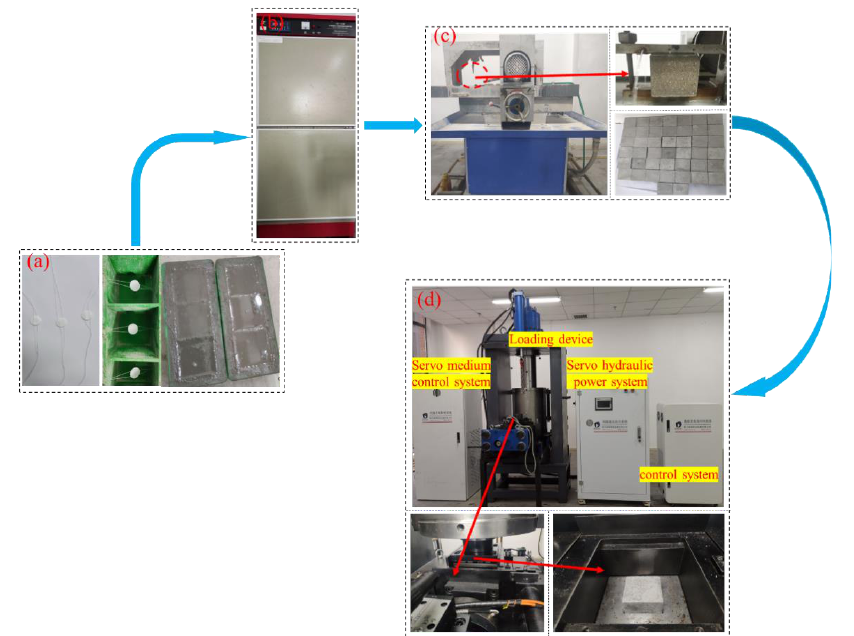
Figure 3. Sample preparation and shear test equipment: ( a ) preparation of the samples before pouring; ( b ) constant temperature and humidity curing box; ( c ) sample grinding process; ( d ) mechanical loading equipment.